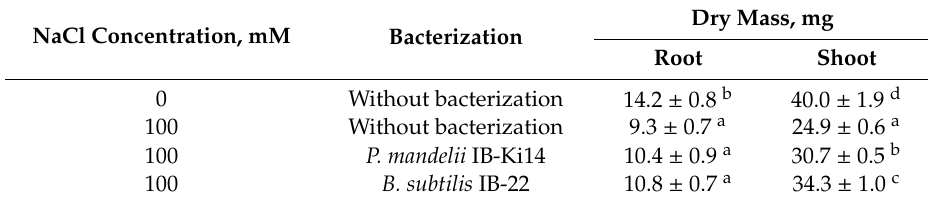
Table 3. Effects of 100 mM NaCl and rhizospehere inoculation with P. mandelii IB -Кi14 and B. subtilis Table 3. E ff ects of 100 mM NaCl and rhizospehere inoculation with P. mandelii IB -Ki14 and B. subtilis IB -22 on the shoot and root dry mass of 14-days-old wheat plants. IB -22 on the shoot and root dry mass of 14-days-old wheat plants.